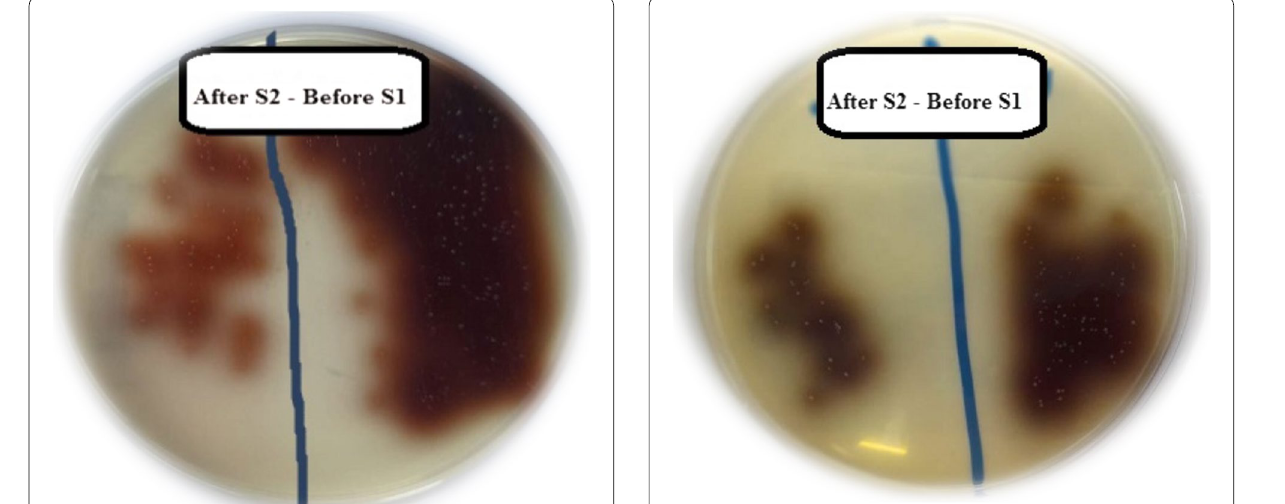
Fig. 7 Culture of S1 and S2 in Ca(OH) 2 paste